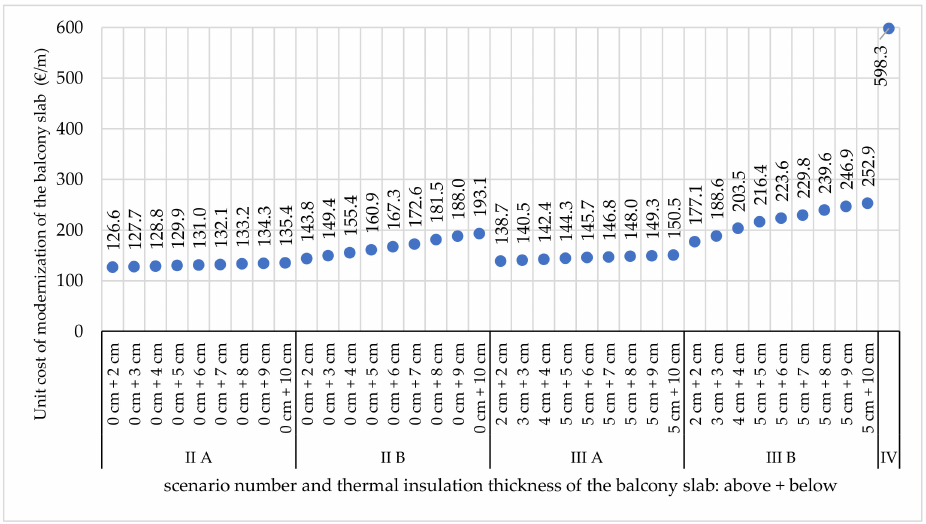
Figure 11. Unit cost of considered individual methods of modernization of balcony